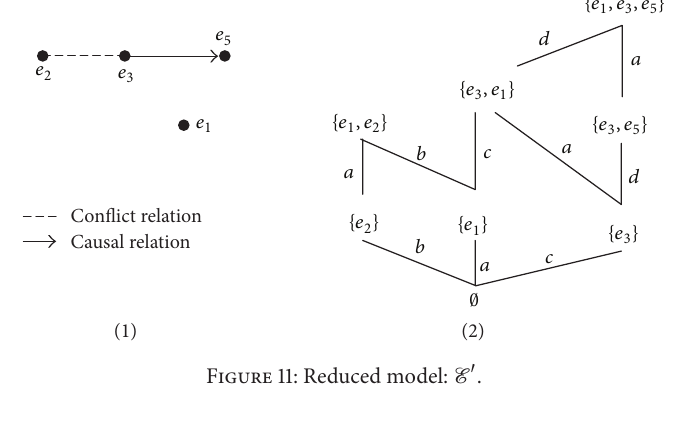
Figure 11: Reduced model: E 󸀠 .